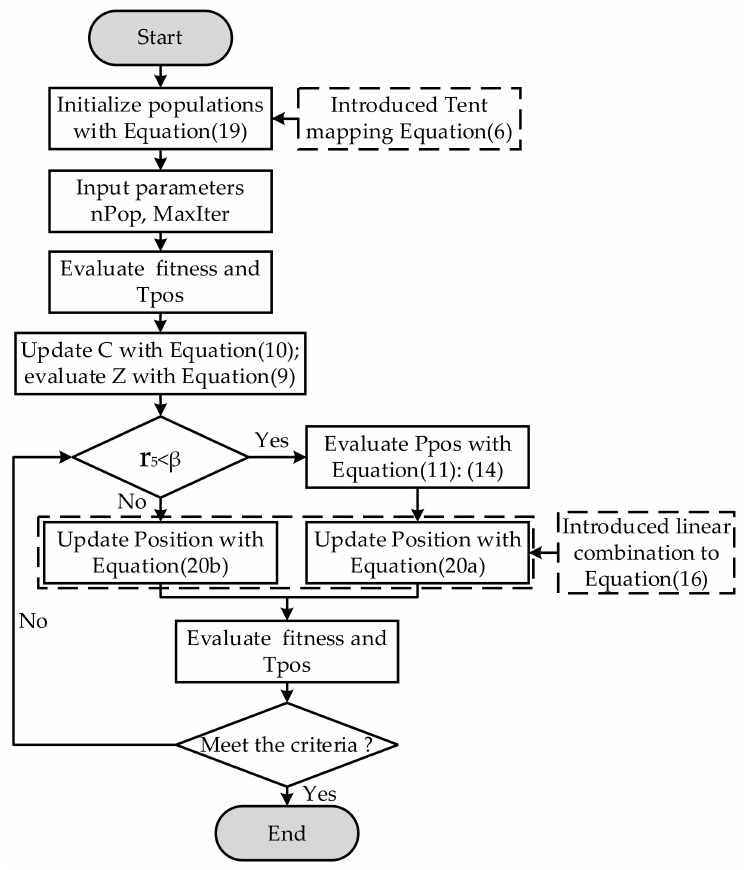
Figure 2. The flowchart of IHPO algorithm.